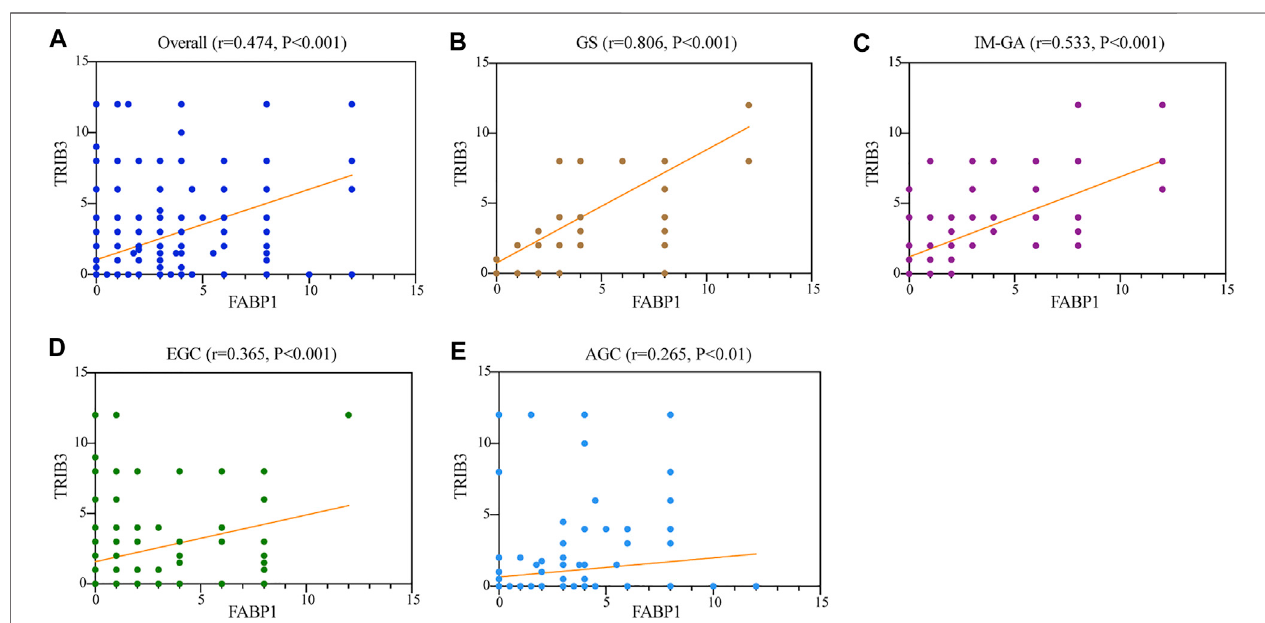
FIGURE 5 | The protein expressions of TRIB3 and FABP1 were signi fi cantly positively correlated in the overall patients (A) , GS (B) , IM-GA (C) , EGC (D) , and AGC (E) .